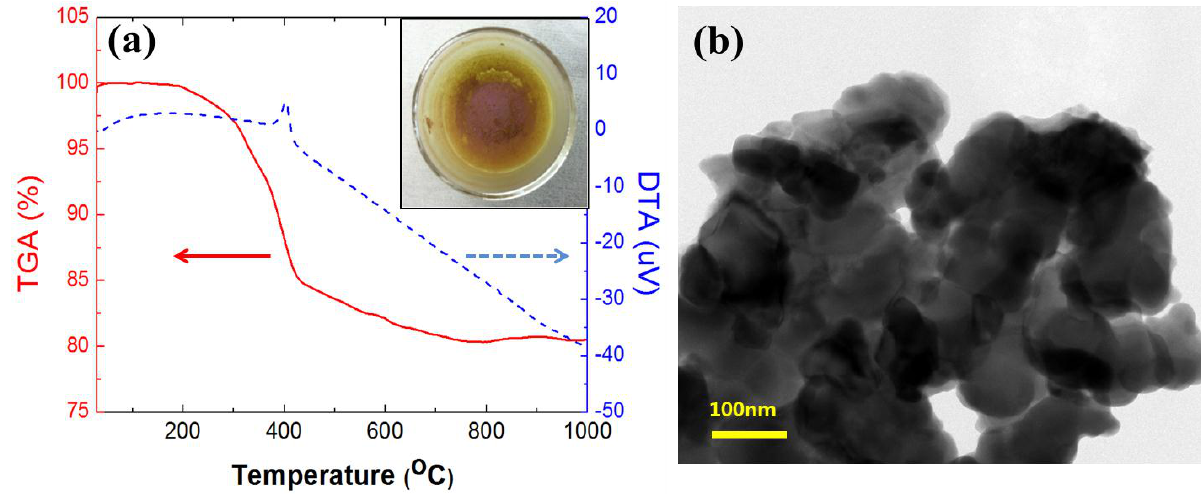
Figure 5. Thermal behavior ( a ) and high-resolution transmission electron microscope (HRTEM) image ( b ) of the recovered ITO powder from TFT-LCD panel after heat treatment at 600